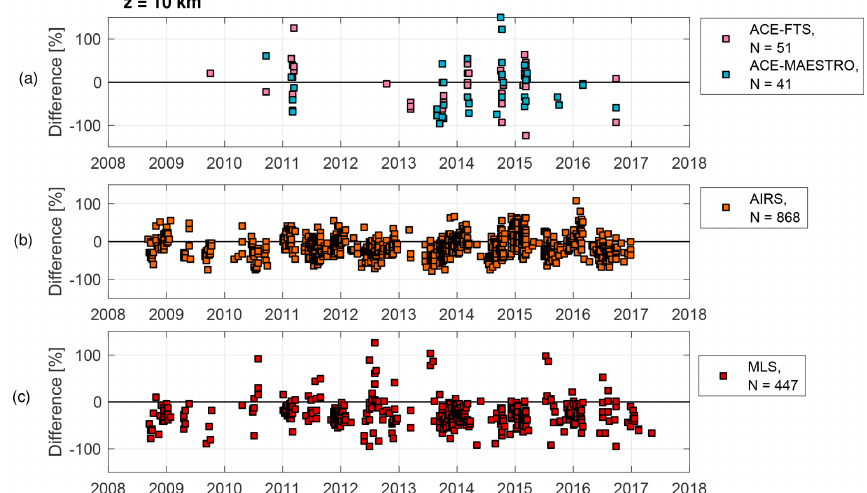
Figure 10. Time series of percent differences between satellite measurements and the Eureka radiosondes at 10km altitude for (a) ACE-FTS and ACE-MAESTRO, (b) AIRS, and (c) MLS. In each case, the differences follow Eq. (3), where the satellite is X and the Eureka radiosonde is Y